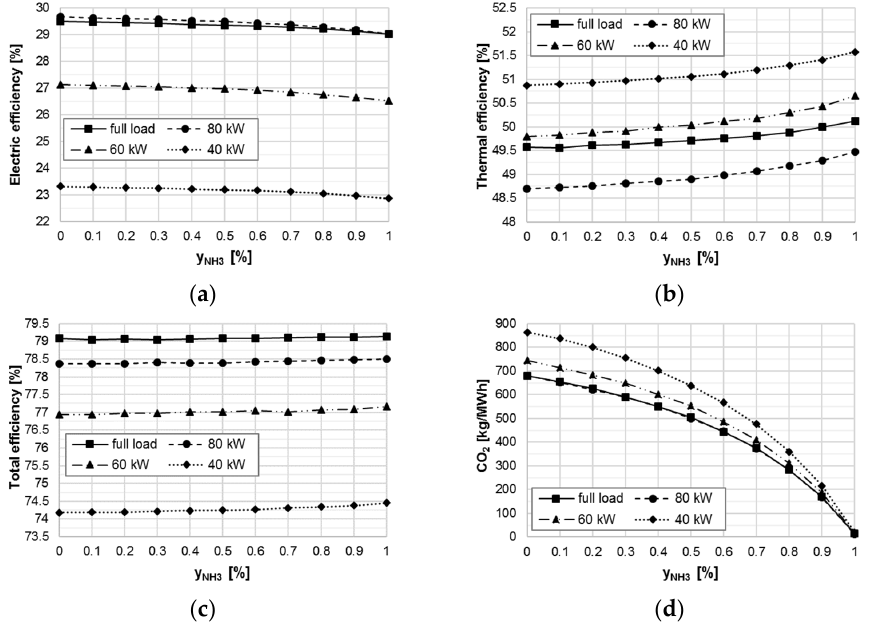
Figure 9. Effects of NH 3 feeding, at different levels of power output, on isentropic efficiency of: ( a ) compressor; ( b ) turbine.